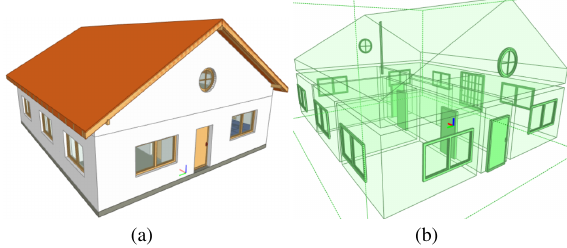
Figure 7. Importing IFC geometric data into IndoorGML.